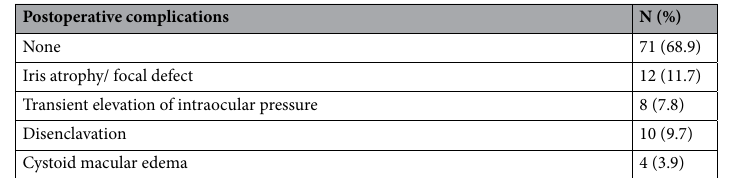
Table 2. Postoperative complications of eyes that underwent retropupillary iris claw intraocular lens (IOL) implantation surgery combined with pars plana vitrectomy for the treatment of an IOL dislocation.